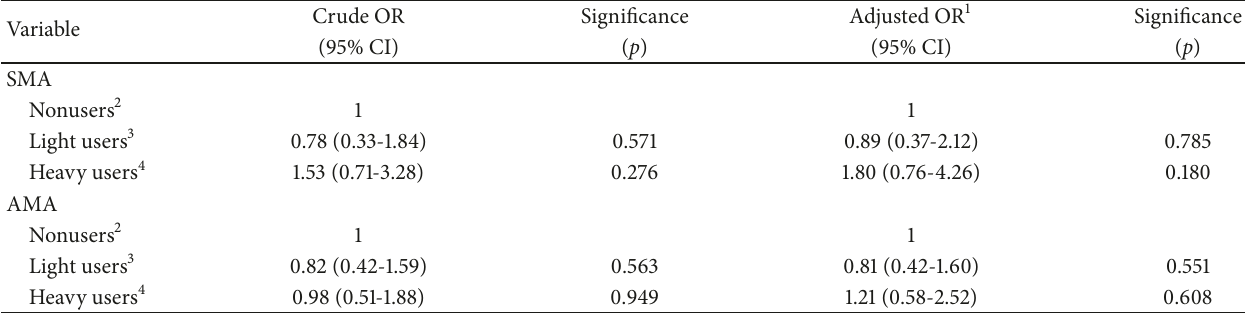
Table 3: Association between khat and frequency of circulating SMA or AMA, by khat